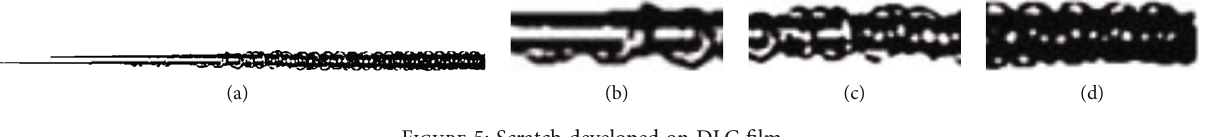
Figure 5: Scratch developed on DLC fi lm. Table 2: Ultimate loads where coatings peeled o ff the substrate during the scratch test.